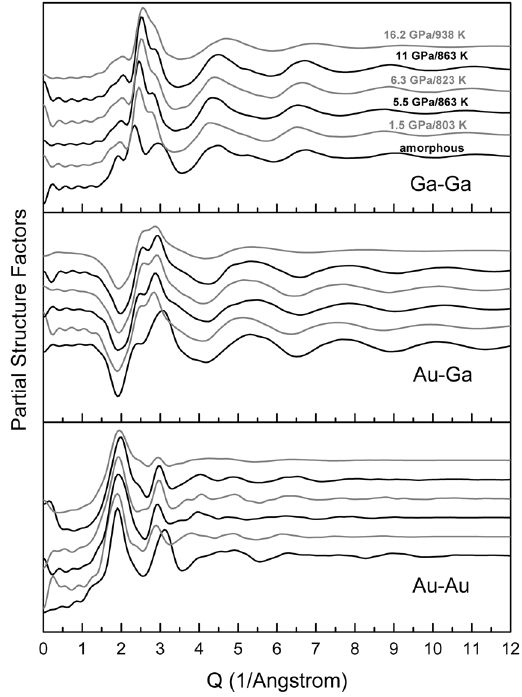
Figure 2. Calculated partial structure factors for amorphous ( P = 0, T = 300 K) and liquid AuGa 2 under pressure. Data are vertically offset for clarity.